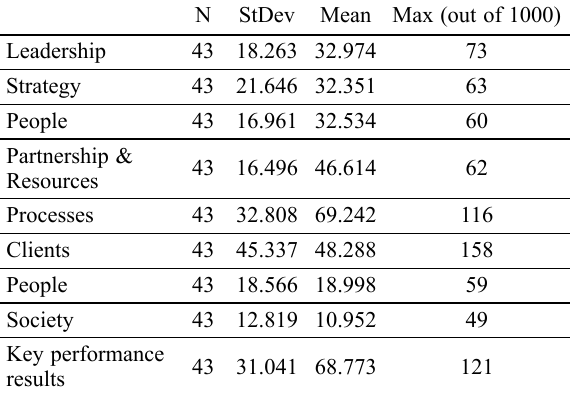
Table 2. Descriptives – all of the perspectives